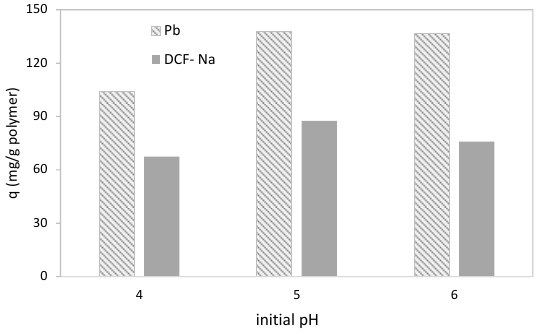
Figure 1. Effect of solution acidity on the simultaneous sorption process. At pH = 5, near the pK a of DCF-Na (~4.2) and the point of zero charge of the sorbent (~4.3), the DCF-Na molecules with the carboxylic groups interacted electrostatically with protonated amino groups inside the composite shell. Moreover, π -stacking, hydrogen bonds, and hydrophobics could favor DCF-Na retention as possible secondary forces inside the shell. The Pb 2+ ions interacted, inside the cross-linked shell, with the amino groups of the PEI by forming coordinative bonds. Due to di ff erent types of pollutant entity inter- actions, coordinative for Pb 2+ and electrostatic/H-bonds/hydrophobics for DCF-Na, we can conclude that the sorption could be additive at the same sorption site inside the cross- linked organic part of the composite. Thus, the DCF-Na sorbed amount is not in fl uenced drastically by the Pb 2+ sorbed amount. DCF-Na can form a complex with lead ions (molar ratio 2:1) [11] and further interact with Pb 2+ as a counter ion, replacing nitrate ions.